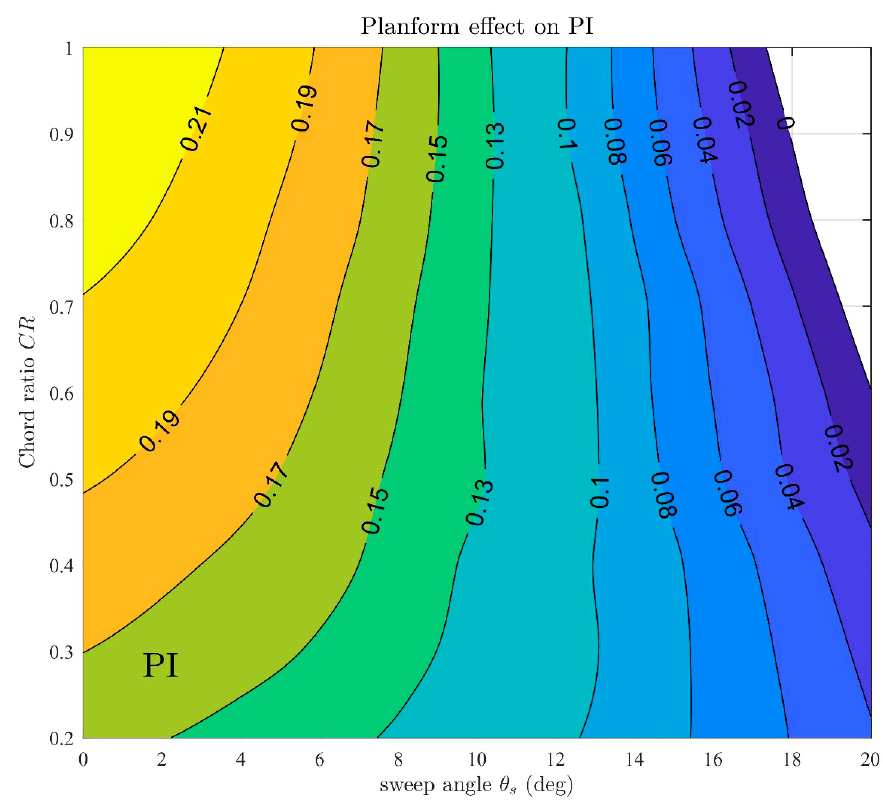
Figure 9. Effect of the planform parameters on the performance of the device. Figure 9. E ff ect of the planform parameters on the performance of the